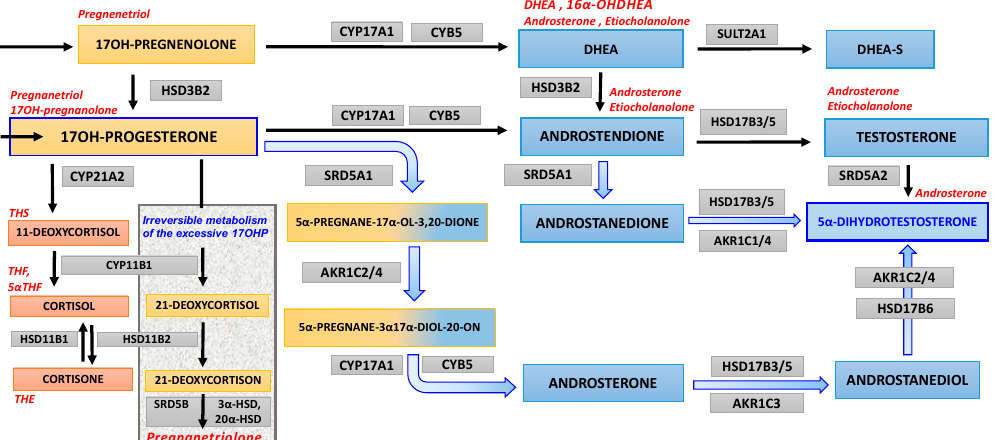
Figure 1. Androgen “backdoor” steroidogenesis pathway. The orange boxes bear the names of the steroid precursors at early stages of steroidogenesis and for 17OHP and its derivatives; reddish boxes for the cortisol pathway and its metabolite; blue areas (and mixed orange / blue) are background for androgens and their precursors; and finally gray boxes bear names of enzymes, which are involved in consecutive steps of steroidogenesis. The bluish arrows depict steps of the androgen backdoor pathway. The left side of the figure presents a few steps of steroidogenesis leading to cortisol synthesis (steroidogenesis beginning from cholesterol towards mineralocorticoid pathway is omitted), which are adjacent the rectangle area displaying the irreversible pathway from 17OH-progesterone to pregnanetriolone, a marker of adrenal origin of 17OHP. The upper row (from 17OH-pregnenolone) presents canonical steroidogenic steps to dehydroepiandrosterone (and its sulfate), which initiate progression of so-called classic androgen pathways toward testosterone and thereafter, to 5 α -dihydrotestosterone. The main substrate appears to be 17OH-progesterone, which fuels (broad bluish arrows) the ”androgen backdoor pathway" and eventually reaches 5 α -dihydrotestosterone with omission of testosterone as an intermediate step. The abbreviations of the enzymes involved in each step are displayed in gray boxes: AKR1C1/4 aldo-keto reductase 1C1/1C4 (3 α HSD), AKR1C2/4 aldo-